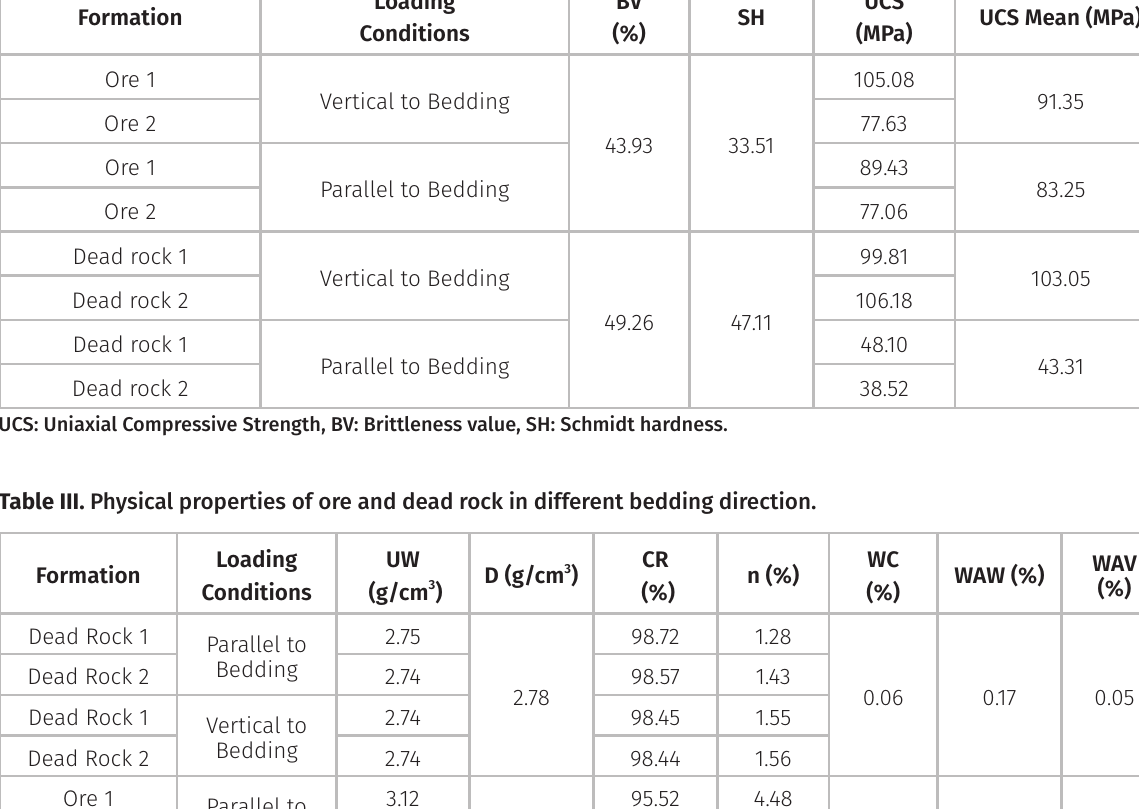
Table II. Geomechanical properties of ore and dead rock in different bedding direction. Formation